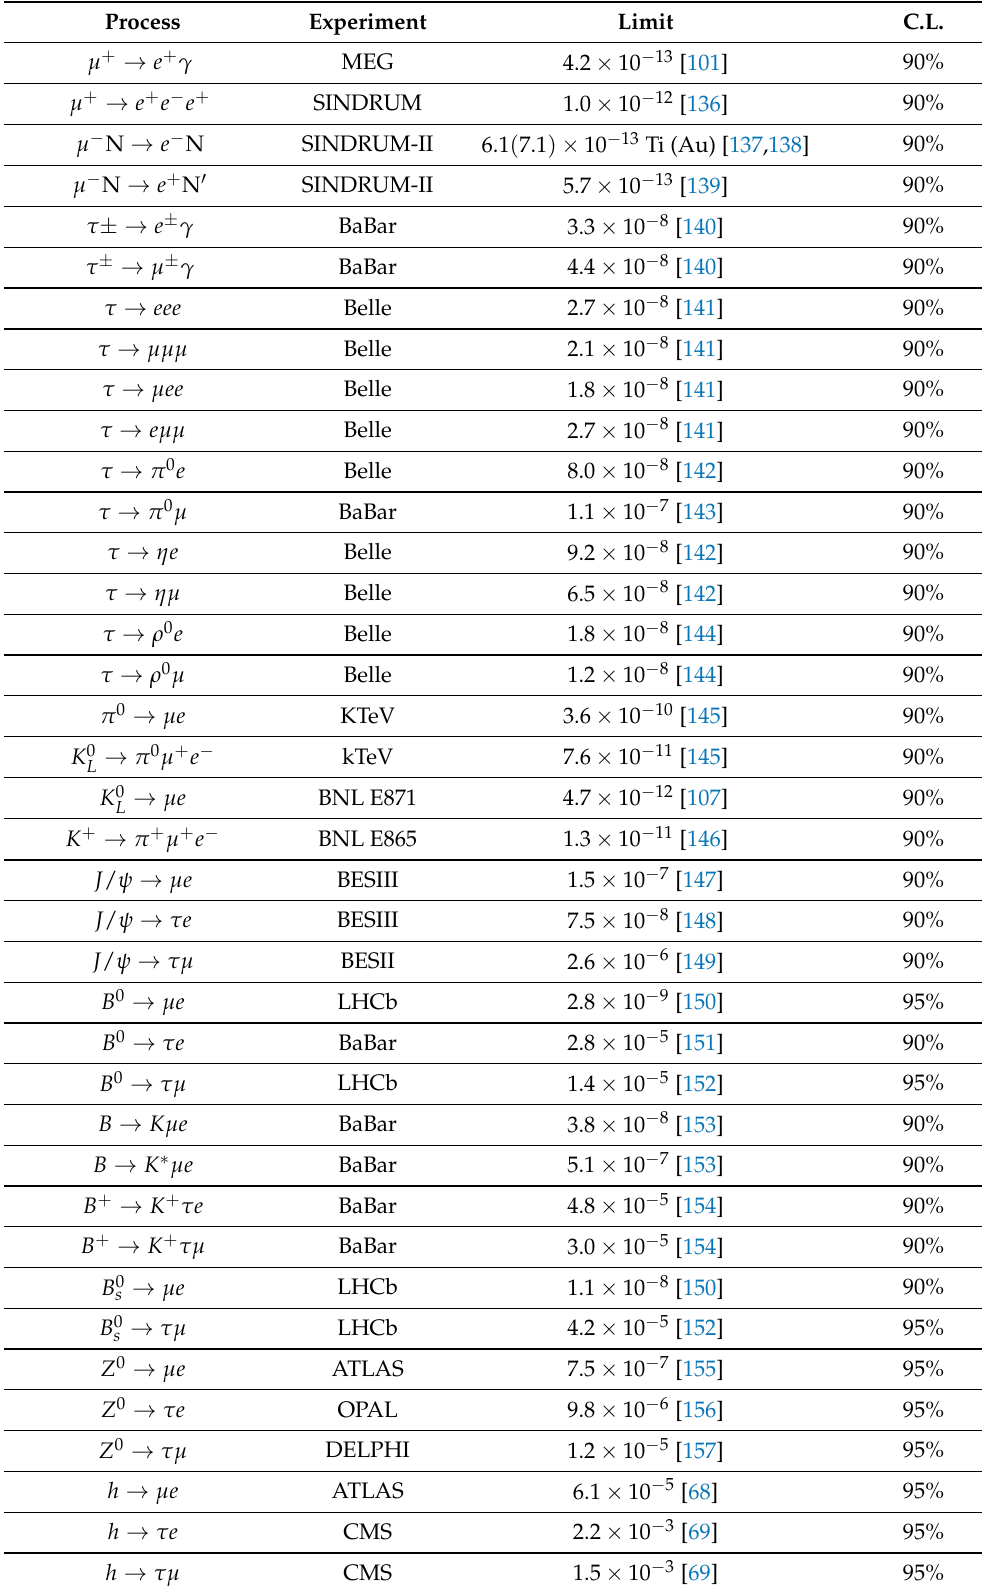
Table 3. Current experimental upper limits on the branching ratios of CLFV processes for muons, taus, mesons ( π , J / ψ , B , K ) and bosons ( Z 0 , h